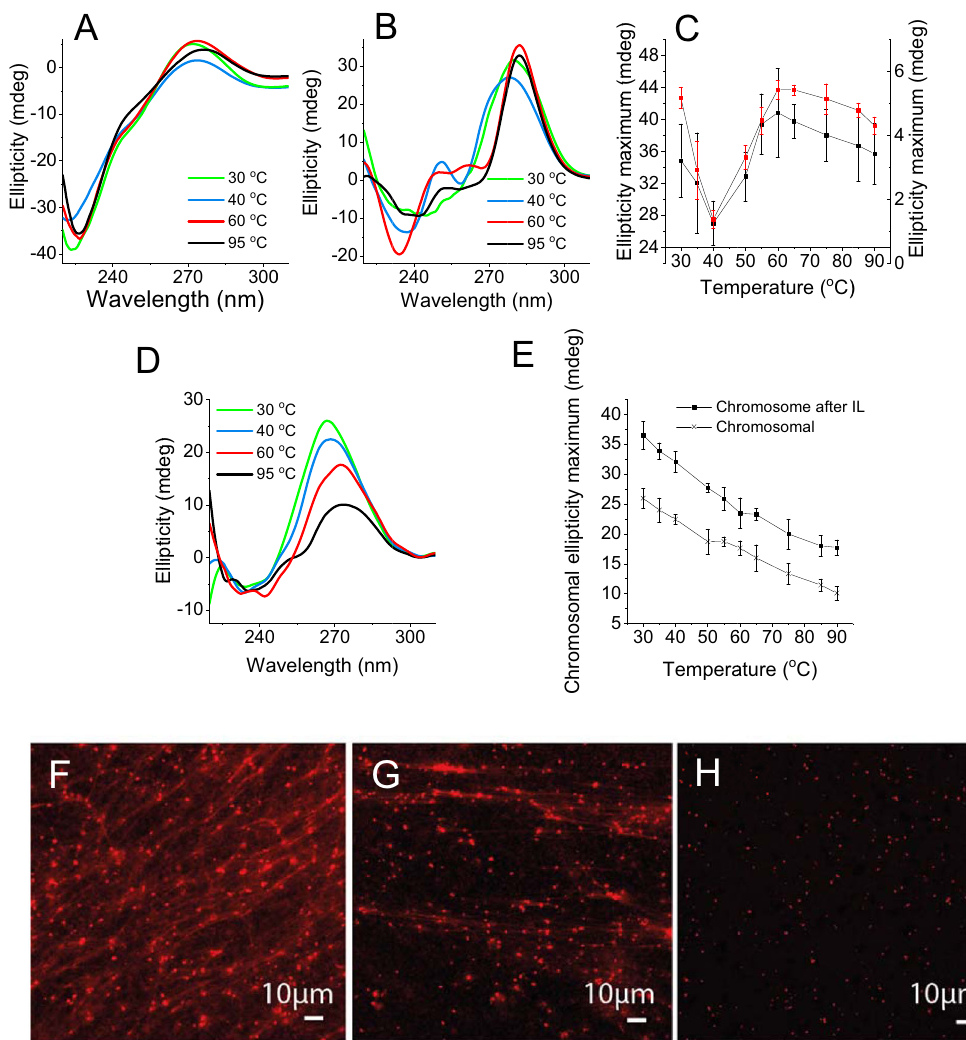
Fig. 2 Biophysical signatures of nucleic acids are consistent with those of the eDNA fi bres and are preserved when isolated. Representative circular dichroism (CD) spectra ( n = 2) of A P. aeruginosa bio fi lm and B eDNA gel isolate at 30 °C (green), 40 °C (blue), 60 °C (red) and 95 °C (black). C Rolling average in amplitude (of fi ve data points) around the mean of dominant NA peak, CD max (260 – 285 nm), from CD spectra of P. aeruginosa bio fi lm (seen in A ) and its extracted extracellular nucleic acid gel (i.e. isolate; seen in B ) from T = 30 to 95 °C. Error bars refer to the standard deviation of the rolling averages. D Representative CD spectra of P. aeruginosa bio fi lm cDNA at 30 °C (green), 40 °C (blue), 60 °C (red) and 95 °C (black). E Rolling average in amplitude (of fi ve data points) around the mean amplitude of dominant NA peak, CD max (260 – 285 nm), from CD spectra of P. aeruginosa bio fi lm cDNA (seen in D ) from T = 30 to 95 °C with and without solubilisation in 1-ethyl-3- methylimidazolium and fractional precipitation. Error bars refer to the standard deviation of the rolling averages. Confocal micrograph of 3- day static P. aeruginosa wild-type bio fi lm with no pre-heating ( F ), with pre-heating to 60 °C ( G ) and pre-heating to 70 °C ( H ) showing eDNA fi bres in the matrix of the bio fi lm, illustrated by binding to DNA-speci fi c dye propidium iodide (red), that partially and completely disappear upon heating to 60 and 70 °C, respectively. Scale bars represent 10 curves (Fig. 2C) that the nucleic acid peak amplitudes, that is, precipitated by perchloric acid, did not self-assemble into gels relative to the initial peak amplitudes at T = 30 °C, follow the same (Supplementary Figure 3D). trend across the temperature pro fi les, with a transition from 40 to Circular dichroism (CD) is a highly sensitive spectroscopic 60 °C. Only representative spectra are presented here to avoid technique for determining the secondary structure of biomole- losing structural information through data averaging. Never- cules, particularly proteins and nucleic acids. It was applied here to theless, nucleic acid peak transitions for eDNA were observed at demonstrate whether the higher-order structure of its eDNA the same temperature in duplicate analyses (Supplementary was preserved during extraction and isolation. Unprocessed Figure 4). In contrast, the nucleic acid peak in cDNA extracted P. aeruginosa bio fi lms displayed a CD peak at 250 – 285 nm from P. aeruginosa planktonic cells decayed steadily with (Fig. 2A), which is consistent with the presence of nucleic acids 34 , increasing temperature (Fig. 2D, E). This was also observed for and this peak dominated the CD spectrum of the gel isolate cDNA processed through the ionic liquid (i.e. EMIM-Ac dissolution (Fig. 2B). Due to the complexity of the bio fi lm matrix, it is not and fractional precipitation). possible to normalise CD, or ellipticity, with concentration. The change in conformation of the nucleic acids was seen to Therefore, scales in Fig. 2A, B are not directly comparable. occur coincident with loss of eDNA fi bres in the wild-type bio fi lm, Nonetheless, it can be observed from changes in the heating